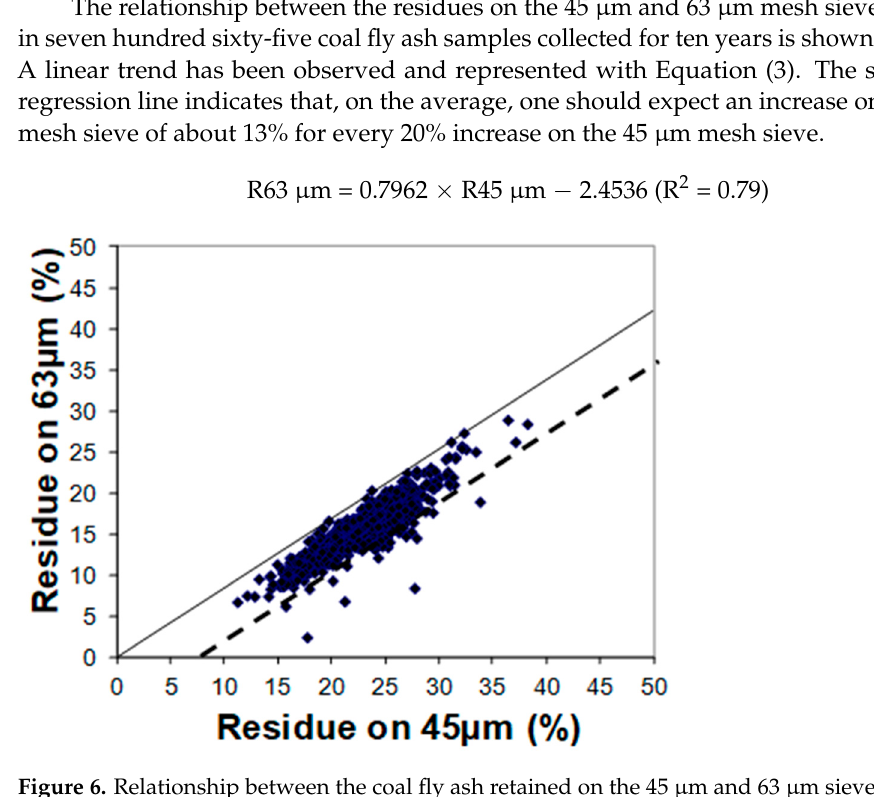
Figure 6. Relationship between the coal fly ash retained on the 45 µ m and 63 µ m sieves, calculated from 765 spot samples picked in a period of ten